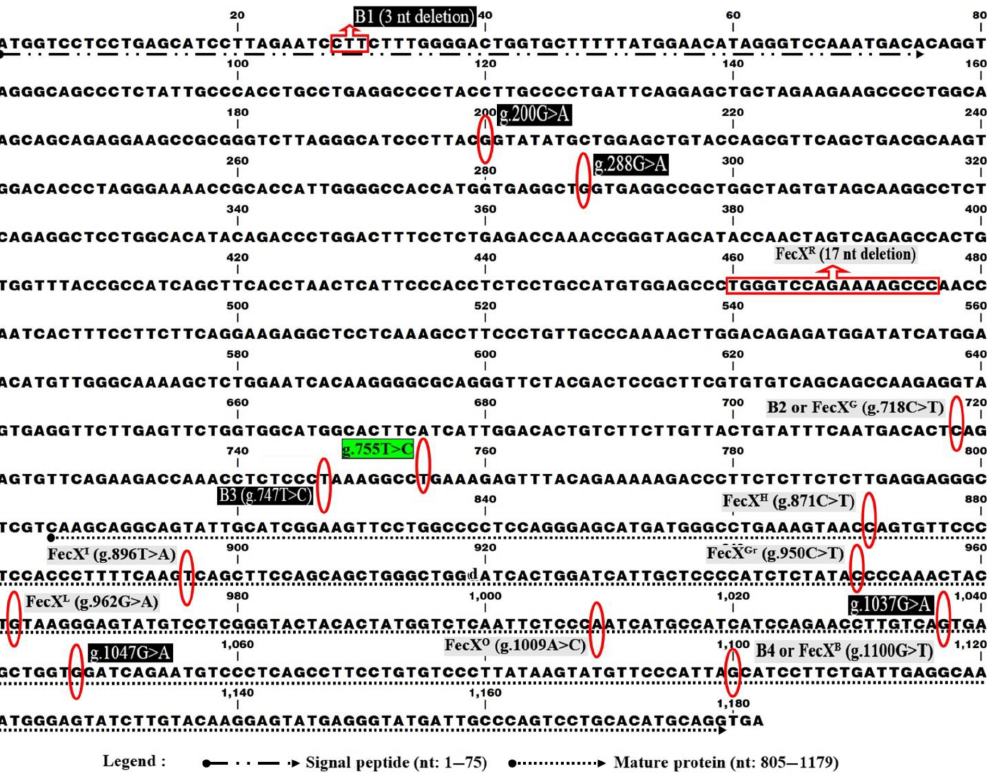
Figure 1. The location and effect of various mutations in ovine BMP15 mRNA (ENSOARG00000009372) on ewe prolificacy. Mutations in the gray box are the effect on the ewe litter size. Mutations in the black box have not been documented to have an effect on the ewe litter size. The T755C mutation, the green box, is the novel mutation that has been detected in Iranian sheep breeds of this